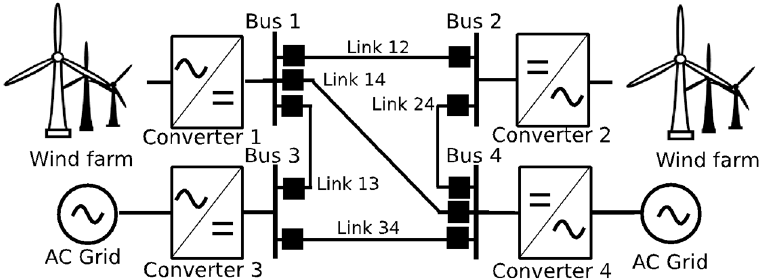
Figure 17. HVDC grid.